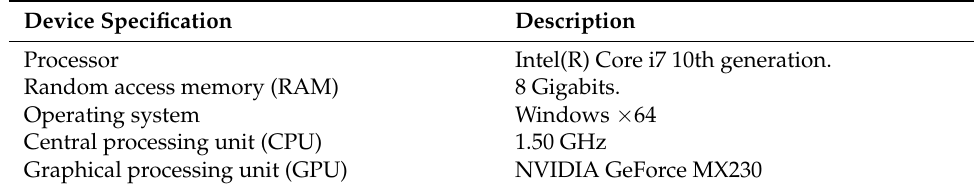
Table 3. Simulation Device